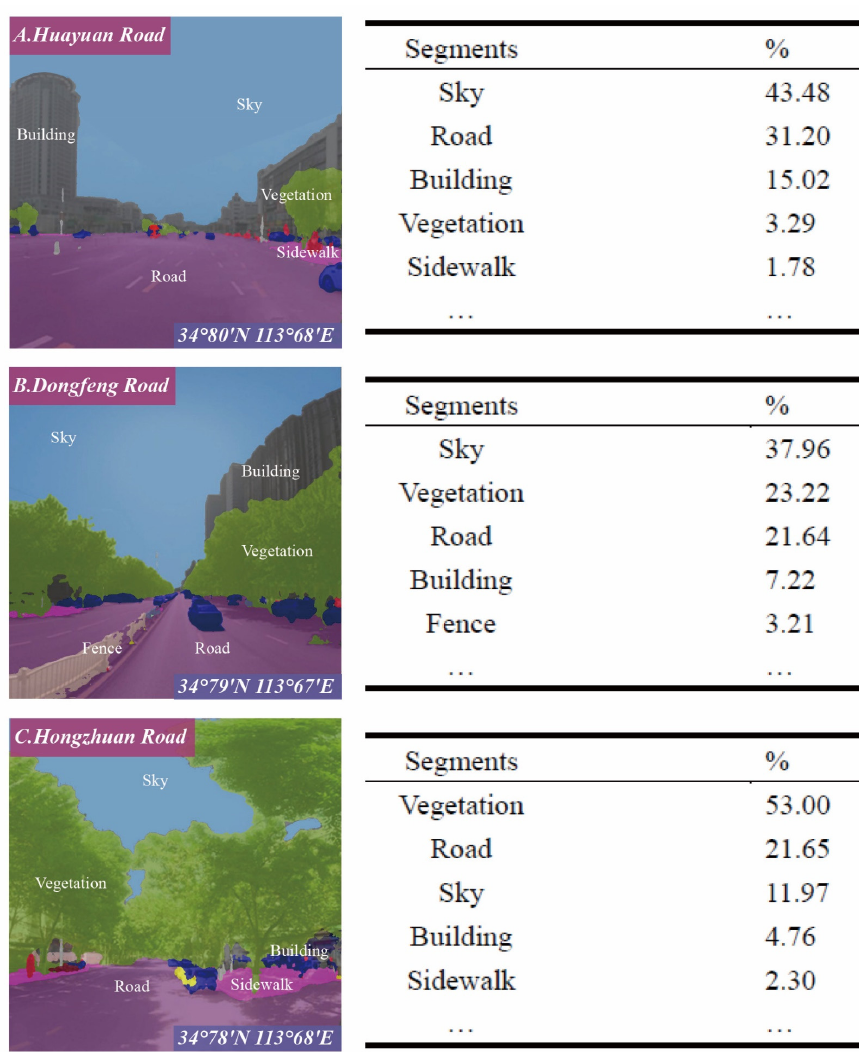
Figure 8. Three semantic segmentation sample cases; ( left ) images, ( right ) results.